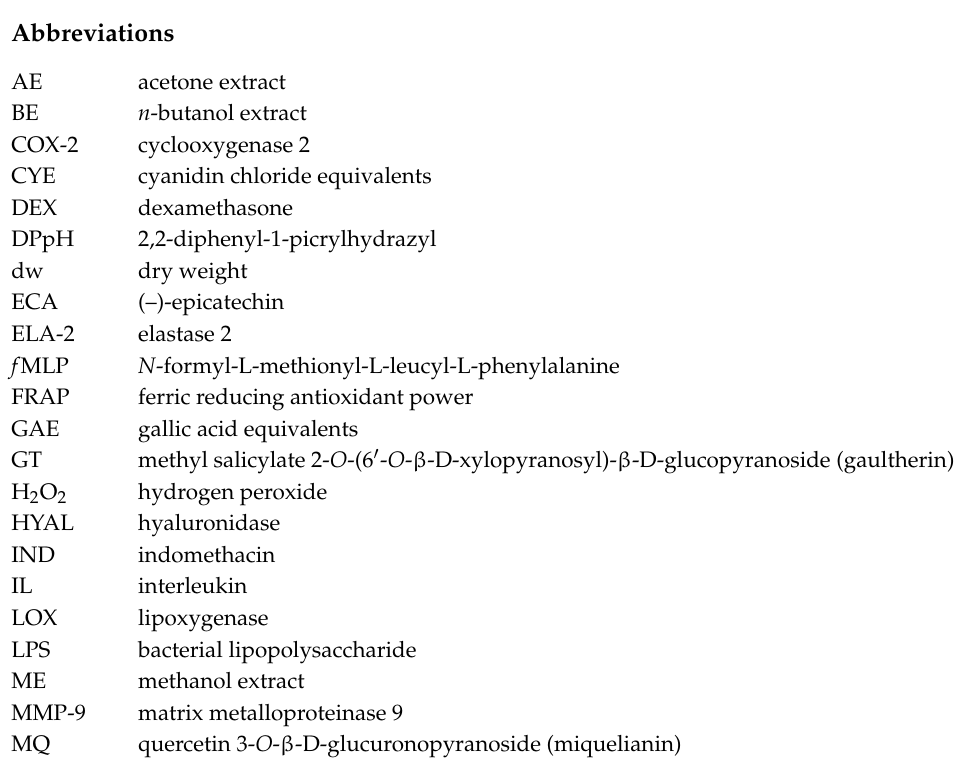
Table S2: Correlation ( r ) coefficients and probability ( p ) values of linear relationships between antioxidant and anti-inflammatory activity parameters and phenolic contents of G. procumbens stem dry extracts; Table S3: Antioxidant activity parameters of G. procumbens stem dry extracts expressed in phenolic